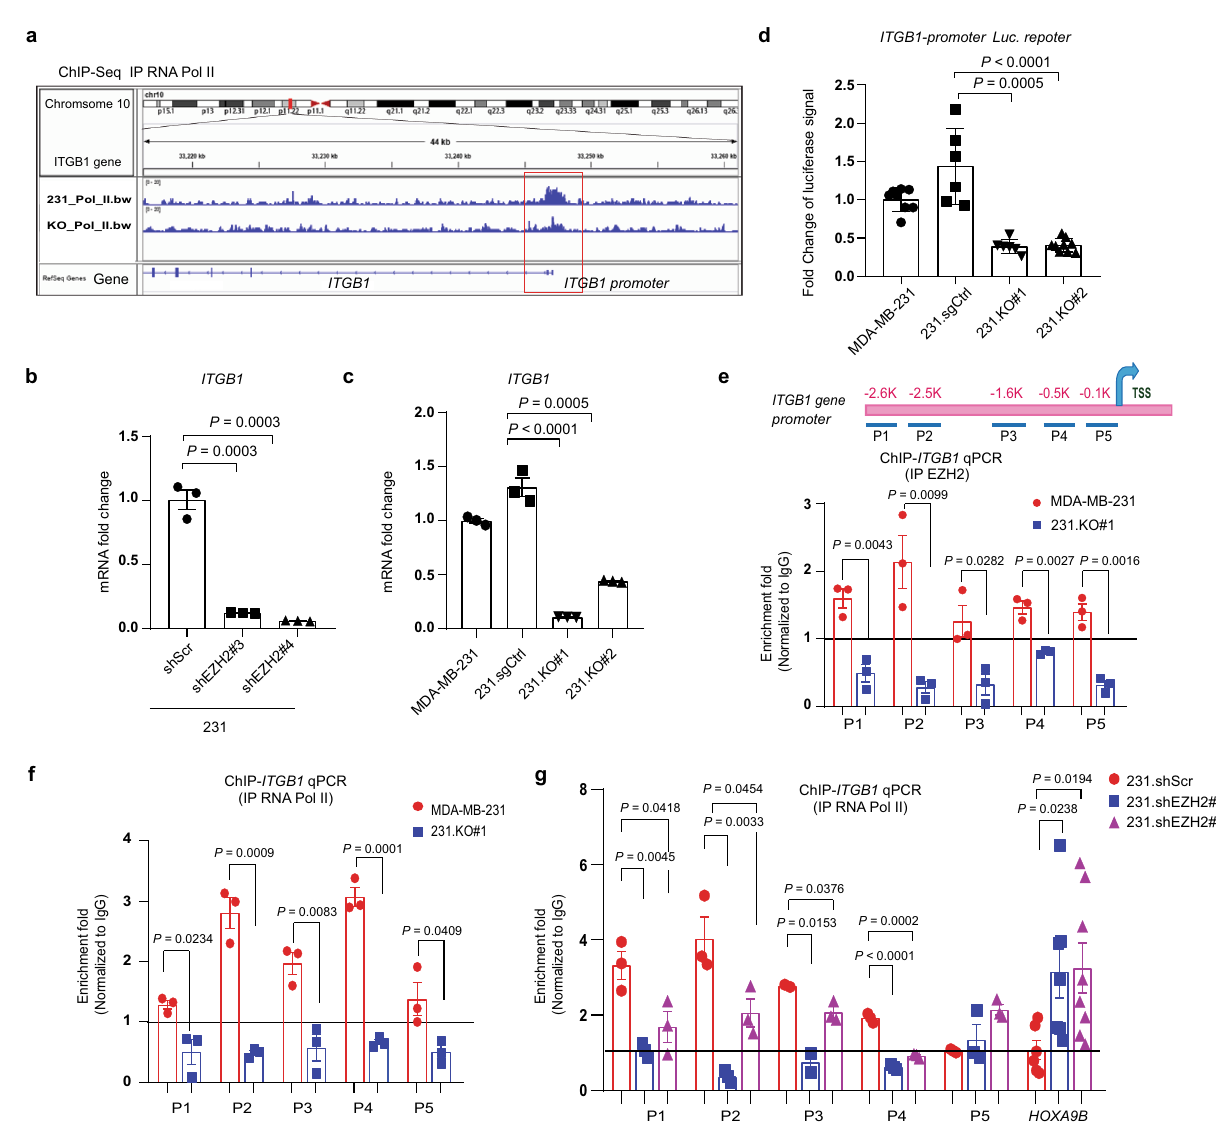
Fig. 5 EZH2 increases the FAK upstream ITGB1 expression. a Screenshot of the RNA Pol II ChIP sequencing (ChIP-seq) signal (GSE188640) at the ITGB1 promoter locus in MDA-MB-231 (231_Pol _II.bw) and 231.KO#1 (KO_Pol_II.bw) cells. b qRT-PCR analysis of ITGB1 mRNA expression in the indicated cells. Data are presented as means± S.E.M. t -test (two-sided). Three biologically independent experiments. c qRT-PCR analysis of ITGB1 mRNA expression in the indicated cells. Data are presented as means ± S.E.M. t -test (two-sided). Three biologically independent experiments. d ITGB1 promoter activity in MDA- MB-231, 231.sgCtrl, 231.KO#1, and 231.KO#2 cells as measured using a dual-luciferase reporter assay. ITGB1 fi re fl y luciferase signal was divided by the control renilla luciferase signal, and the ratios of luciferase/renilla in four cell lines were normalized to that of MDA-MB-231 cells. n = 6 biologically independent experiments in 231.sgCtrl and 231.KO#1 cells; n = 8 biologically independent experiments in MDA-MB-231 cells, n = 9 biologically independent experiments in 231.KO#2 cells. Data are means ± SEM, t -test (two-sided). e Top: the locations of the primers at the ITGB1 gene promoter area for ChIP-qPCR. TSS, transcription start site. Bottom: EZH2 was immunoprecipitated from MDA-MB-231 and 231.KO#1 cells, and EZH2 binding to ITGB1 in the cells was detected using qPCR with the indicated primers. All fold-enrichment values were normalized according to IgG values. Three biologically independent experiments. Data are presented as means ± S.E.M. t -test (two-sided). f RNA Pol II was immunoprecipitated from MDA-MB-231 and 231.KO#1 cells, and RNA Pol II binding to ITGB1 in the cells was detected using qPCR with the indicated primers. All fold-enrichment values were normalized according to IgG values. Three biologically independent experiments. Data are presented as means ± S.E.M. t -test (two-sided). g RNA Pol II was immunoprecipitated from 231.shScr, 231.shEZH2#3, and 231.shEZH2#4 cells, and RNA Pol II binding to ITGB1 or HOXA9B in the cells was detected using qPCR with the indicated primers. HOXA9B was used as a negative control. All fold-enrichment values were normalized according to IgG values. Three biologically independent experiments using P1-P5 primers; six biologically independent experiments using HOXA9B primer. Data are presented as means ± S.E.M. t -test (two-sided). All P values are indicated in the fi gures. ChIP-qPCR using a series of PCR primers that bind to various 231.KO#1 cells, binding of EZH2 to these loci of ITGB1 promoter regions of the ITGB1 promoter from − 2.6 kb upstream of (primer was lost (Fig. 5e, bottom). Our ChIP-EZH2-qPCR assays showed P1) to near (primer P5), the ITGB1 transcription start site that EZH2 binds to ITGB1 promoter almost at the level of EZH2 (Fig. 5e, top). In MDA-MB-231 cells, EZH2 was recruited to the binding to HOXA9B , a well-known methyltransferase substrate ITGB1 promoter from P1 to P5 loci, and expectedly, in of EZH2 35 , with no binding to a non-substrate gene promoter NATURE COMMUNICATIONS| (2022) 13:2543